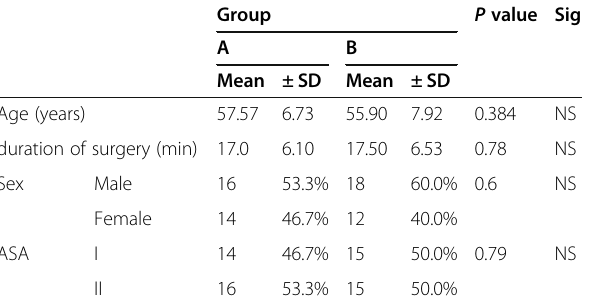
Table 1 Patients ’ characteristics and duration of surgery